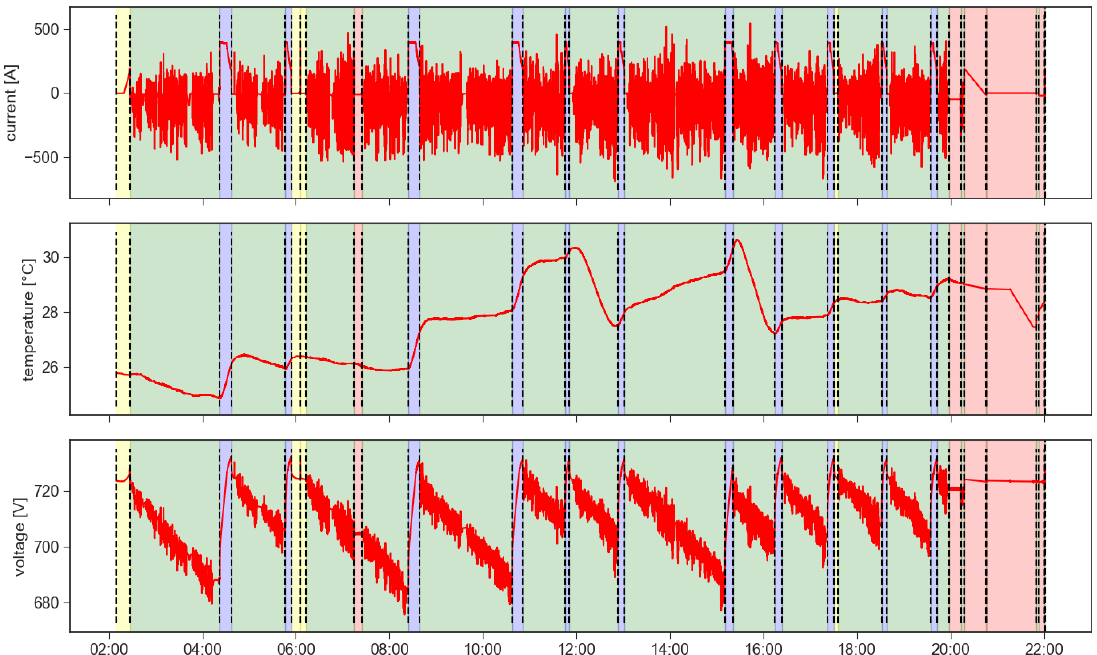
Figure 1. Typical usage profile of a bus that uses opportunity charging. Operation sections are shown in green. Charging times are marked blue, idle times are yellow and data gaps are red.